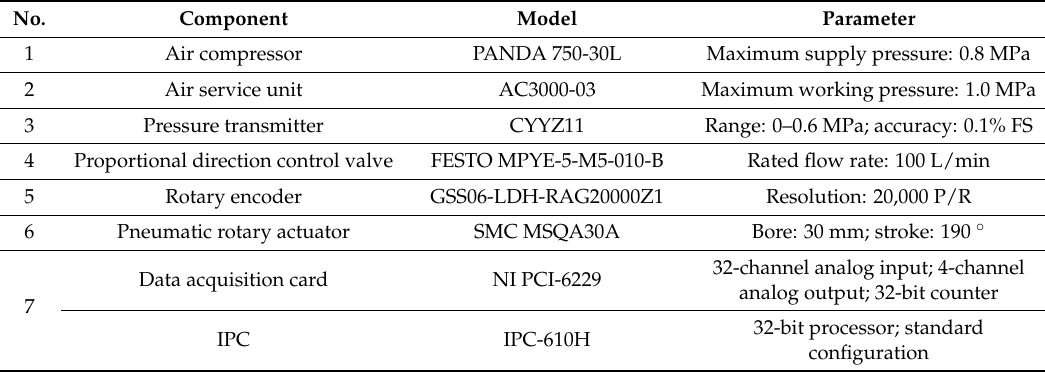
Figure 2. Experimental platform of the pneumatic rotary actuator position servo system. Table 1. Models and parameters of main components.